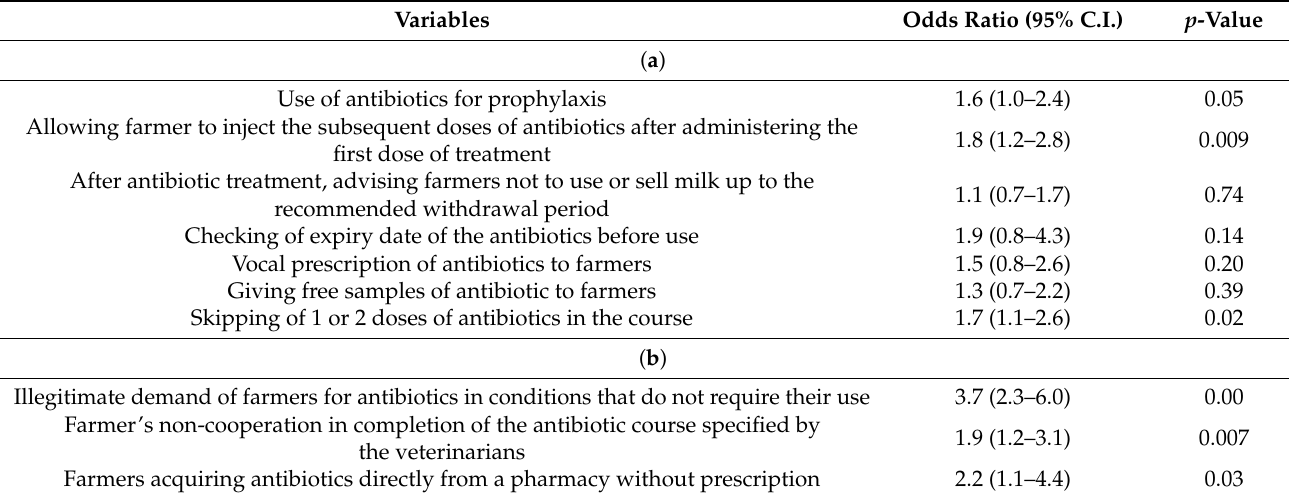
Table 4. Univariable analysis: ( a ) Veterinarians; ( b ) Farmers.